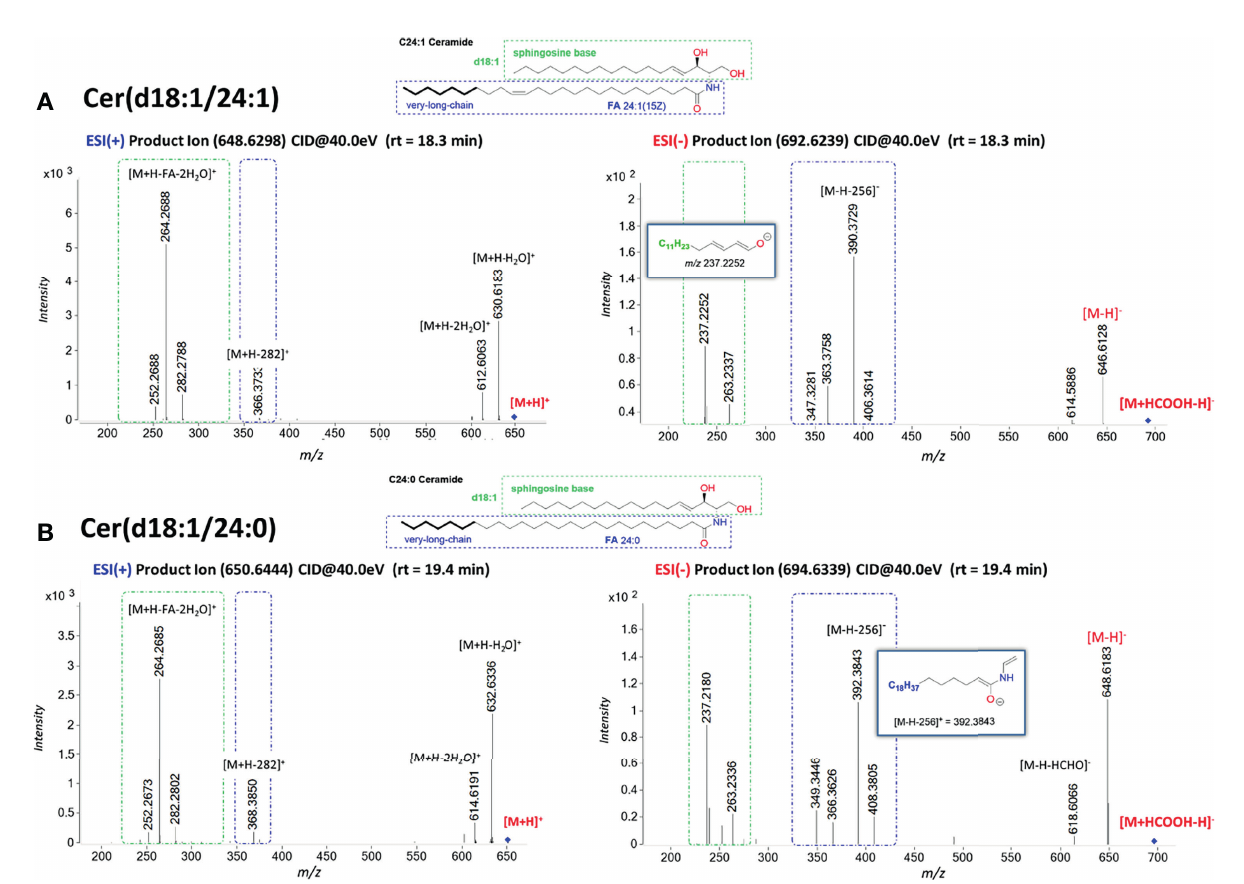
FIGURE 3 | Characteristic MS/MS fragmentation pattern for structural characterization of fatty acyl composition. (A) MS/MS spectra in ESI(+) and ESI( − ) for Cer (d18:1/24:1); (B) MS/MS spectra in ESI(+) and ESI( − ) for Cer(d18:1/24:0). The fragment ions arising from losses of H 2 O, HCHO, and H 2 O + CHOH are common ions seen for all Cer. Fragment ions possessing dLCB are framed in a green dashed square, and fragment ions possessing an FA chain structure are framed in a blue dashed square. Cer with saturated FA are more retained in reverse-phase chromatography than the one with unsaturated double bonds. The fragment ion of [M-H- 256] − arising from the combined losses of H 2 O and the LCB as an aldehyde is a common ion observed for ceramides with a dLCB(18:1) (47, 49).